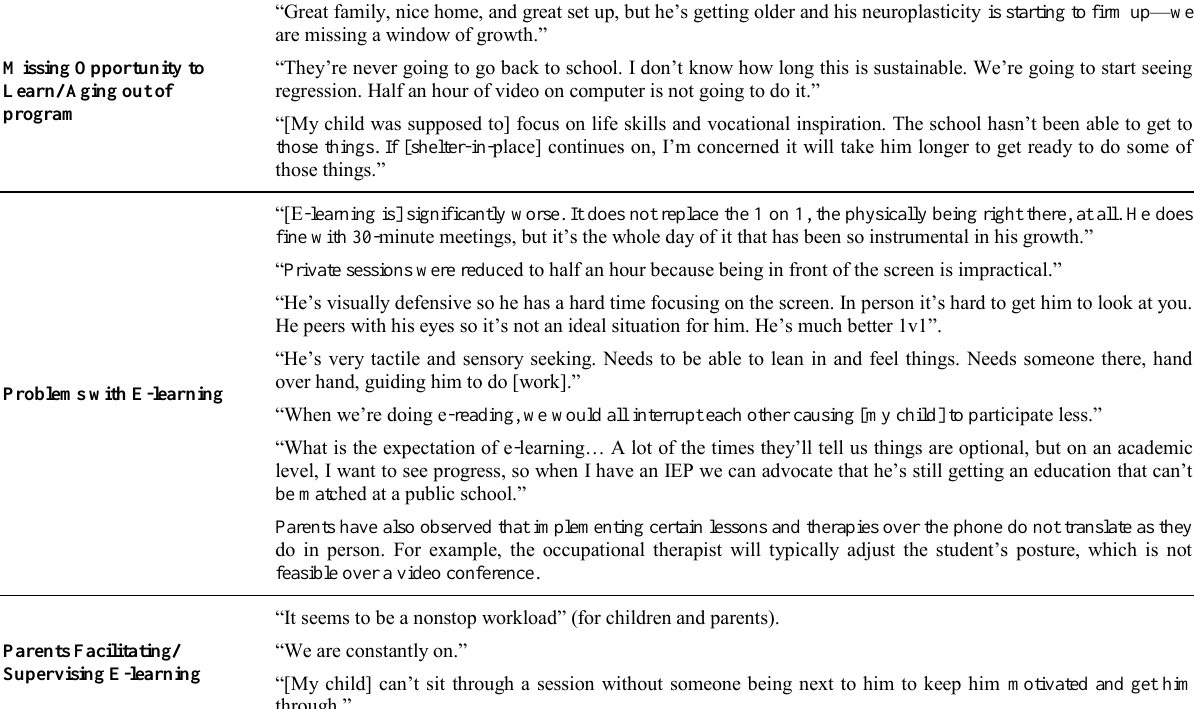
Table 1. Additional Parent